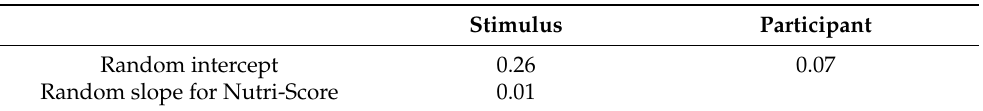
Table 9. ICC random effect terms in mixed-effects model with a random slope for NS in the subset of participants presented with NFP stimuli.